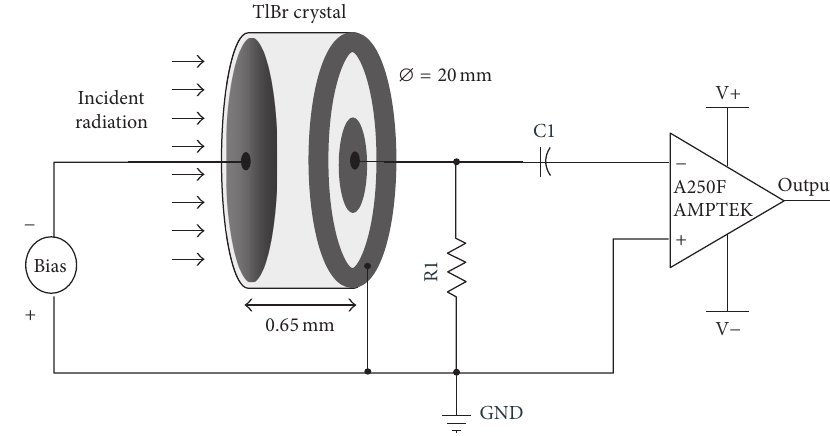
Figure 2: TlBr detector and preamplifier